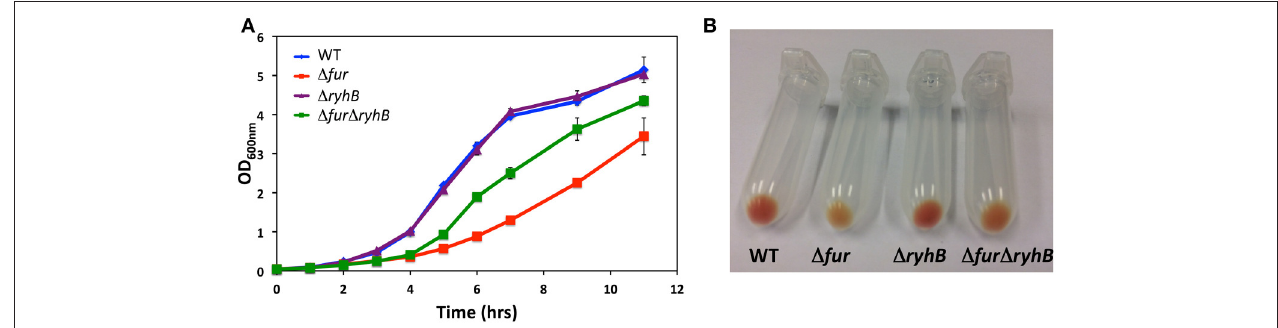
FIGURE 1 | Deletion of ryhB nearly abolishes the phenotypes of a fur mutant. (A) Growth of S. oneidensis wild-type, 1 fur , 1 ryhB , and 1 fur 1 ryhB strains in LB medium at 30 ◦ C with shaking. (B) Bacterial pellets of stationary phase cultures of S. oneidensis wild-type and mutants.